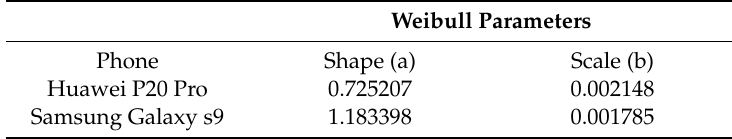
Table 7. Weibull parameters observed from each model comparison for distressed Section 3.